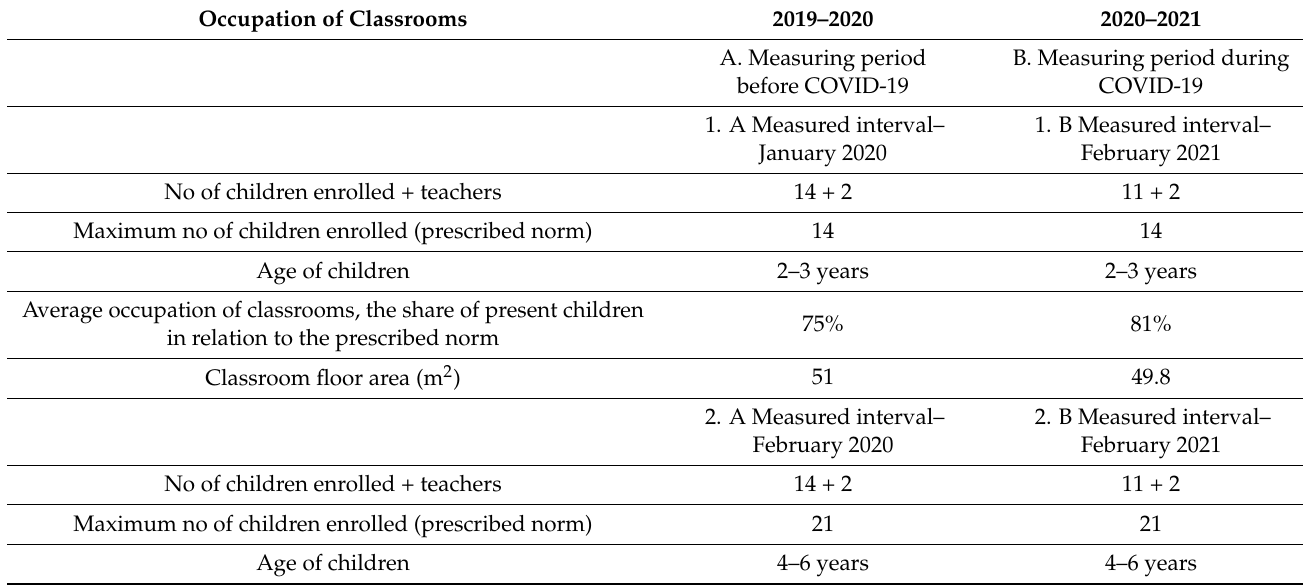
Table 7. Occupation of classrooms, share of children present in relation to the prescribed norm, maximum number of children enrolled and classroom floor area.